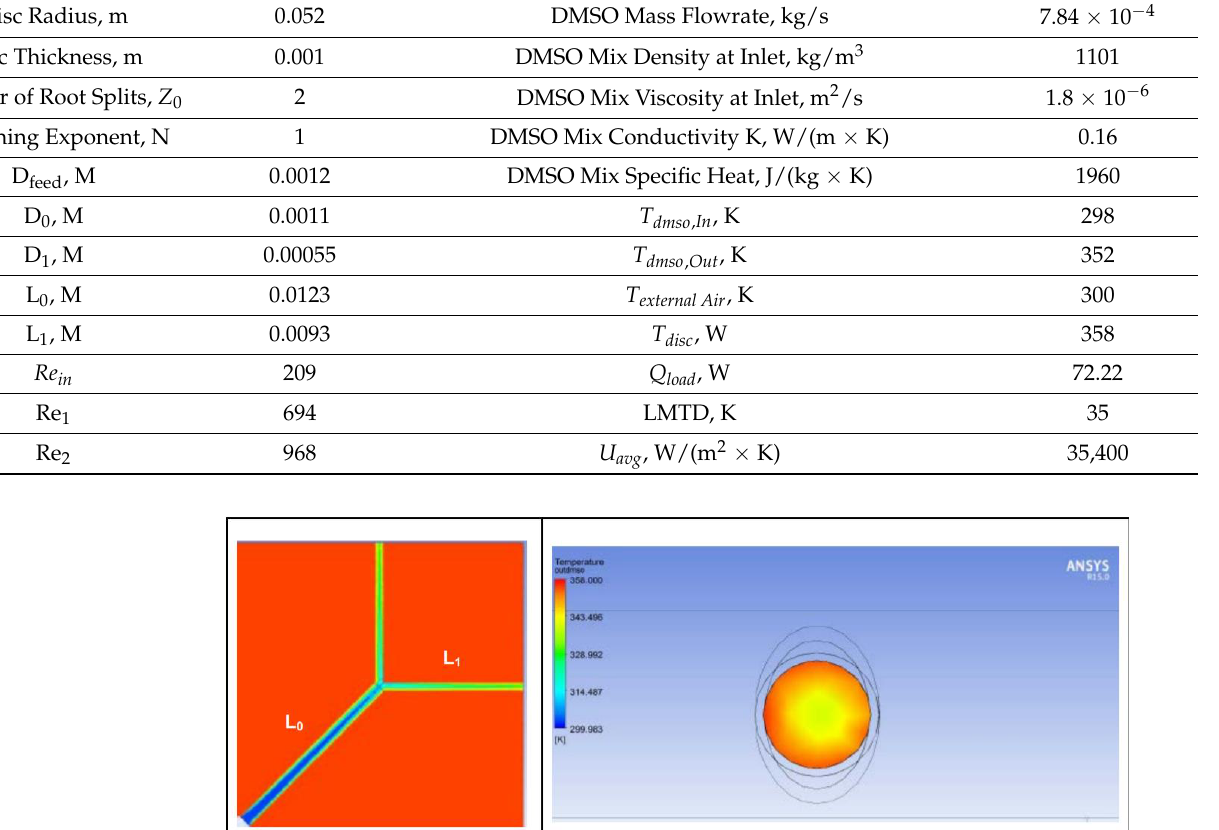
Table 4. A DMSO-cooled ultra-micro DSHE.